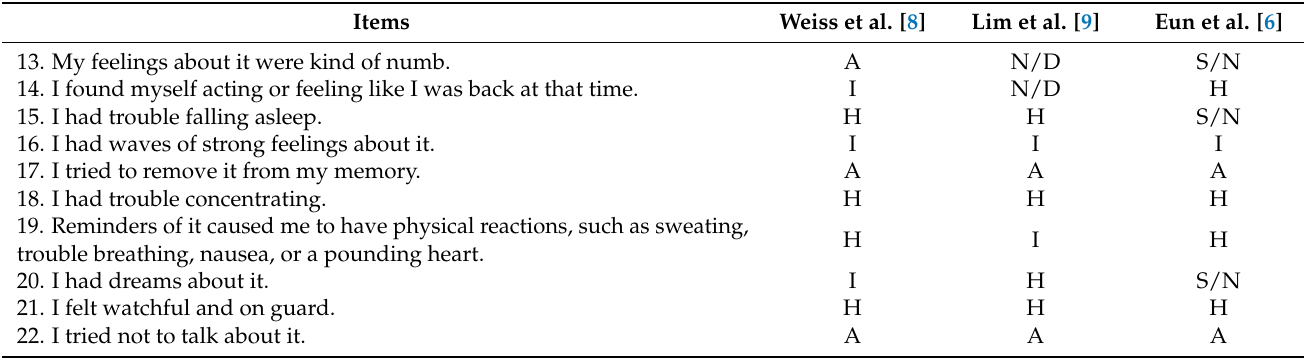
= 0.10, SRMR = 0.04, CFI = 0.89, TLI = 0.87, AIC = 11175.01, BIC = 11481.03, and the fit of SRMR = 0.03, CFI = 0.93, TLI = 0.90, AIC = 11060.54, BIC = 11436.91. Additionally, it was difficult to identify each structure by the result of a two-factor analysis (Appendix). Therefore, the study decided to use three factors. The factor loading and internal consistency of the items are shown in Table 3.